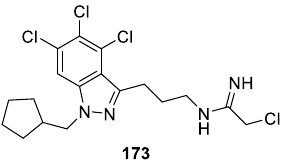
Figure 54. Chemical structure of N -alkylated-1 H -indazole derivative 173 .